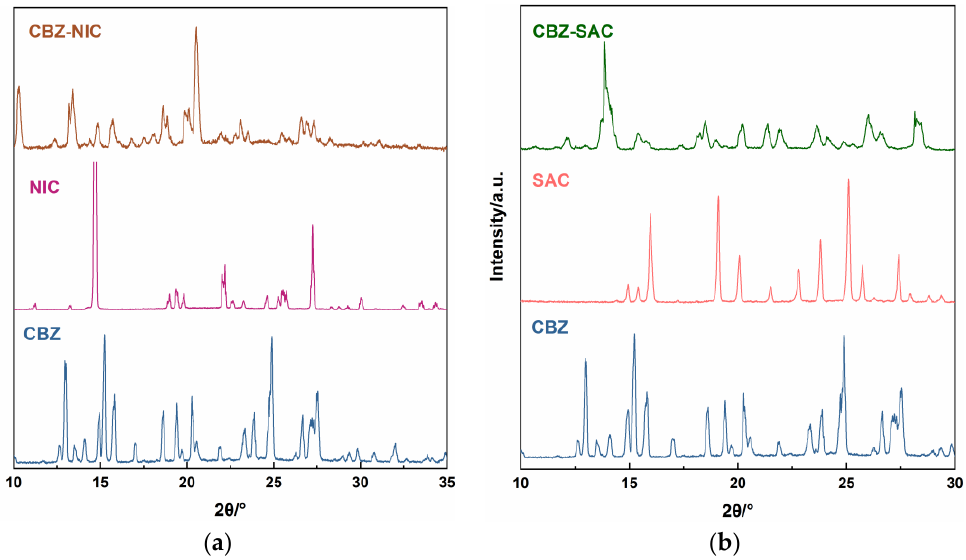
Figure 3. Experimental PXRD patterns of ( a ) CBZ-NIC and ( b ) CBZ-SAC co-crystals with their individual constituents.